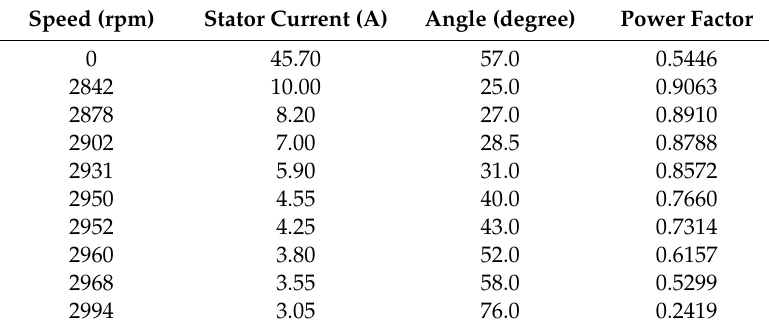
Table 21. Measured results from [46].